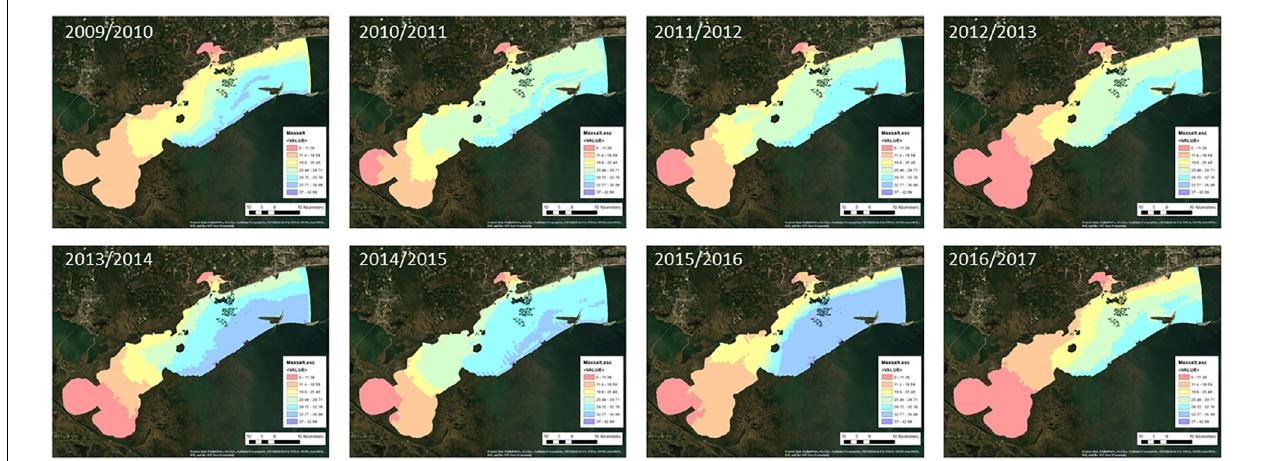
FIGURE 2 | Maximum daily salinity per oyster year.